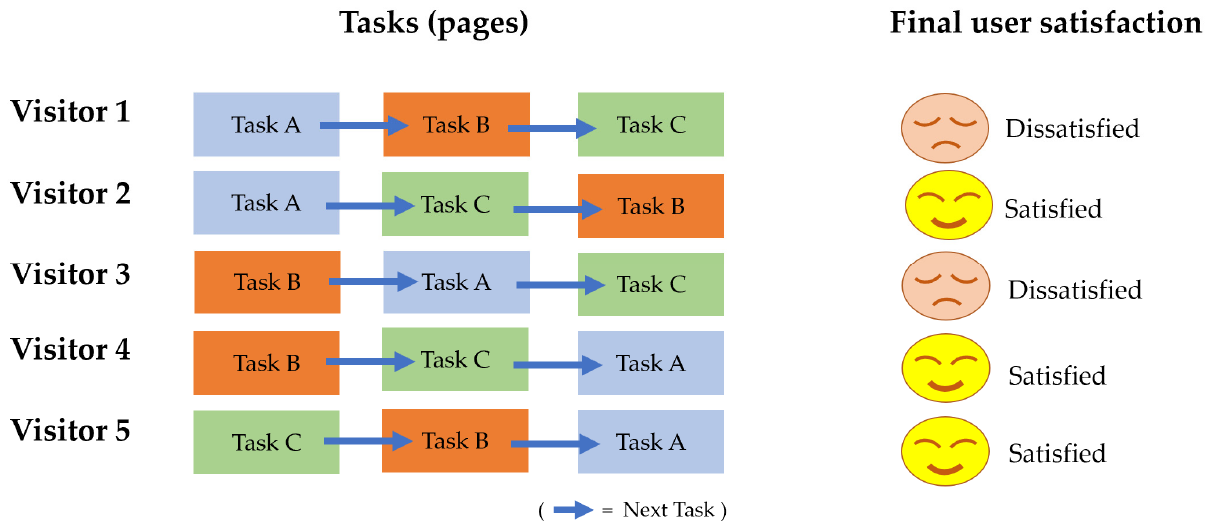
Figure 5. Example of randomly ordered tasks when users use an online shopping website.